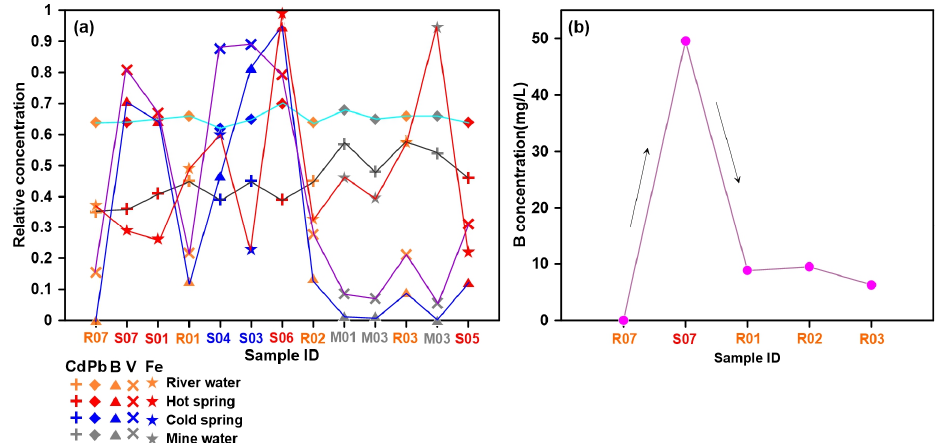
Figure 10. ( a ) The covariant relationship of Cd, Pb, B, V and Fe along the river direction; ( b ) Variations of B concentrations of Langmai River waters along the flow direction.